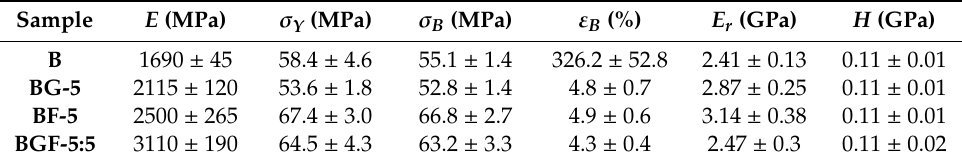
Figure 3. SEM micrograph of the cross-section is of the hybrid PETG filament containing 5 wt.% of the EG and 5 wt.% of CF. The image was obtained by a scanning electron microscope at a 175× magnification under an electron beam. Table 13. Mechanical properties of recycled PETG